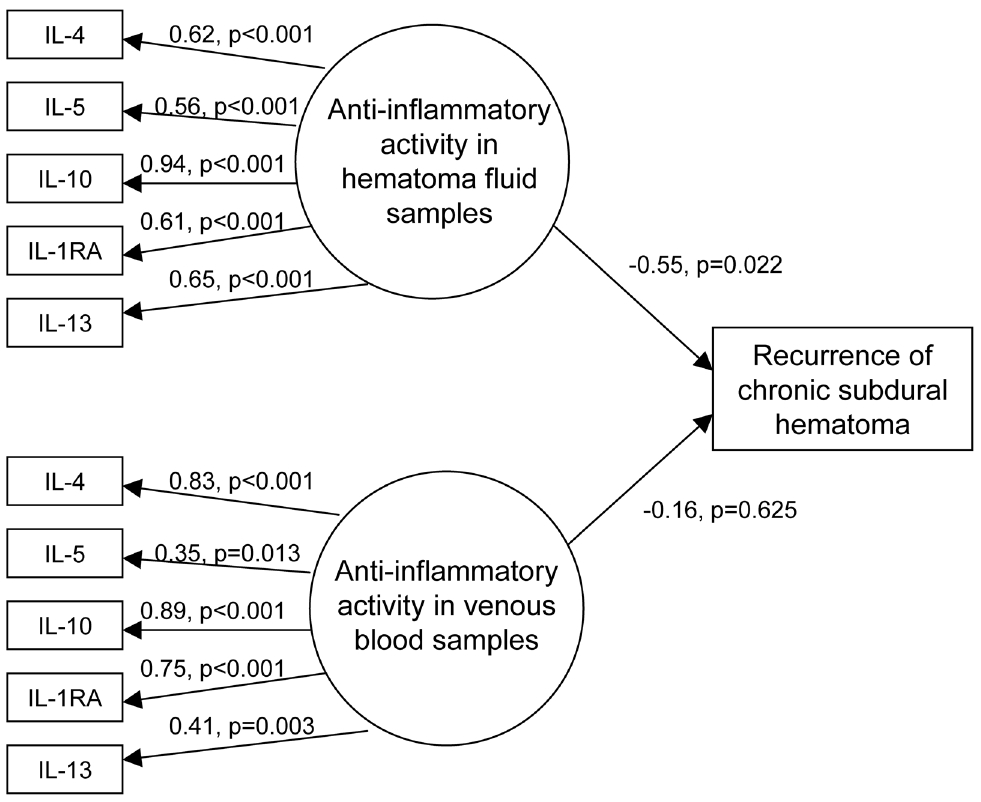
Figure 2. Structural equation model on relationship between anti-inflammatory activity and risk of recurrence.